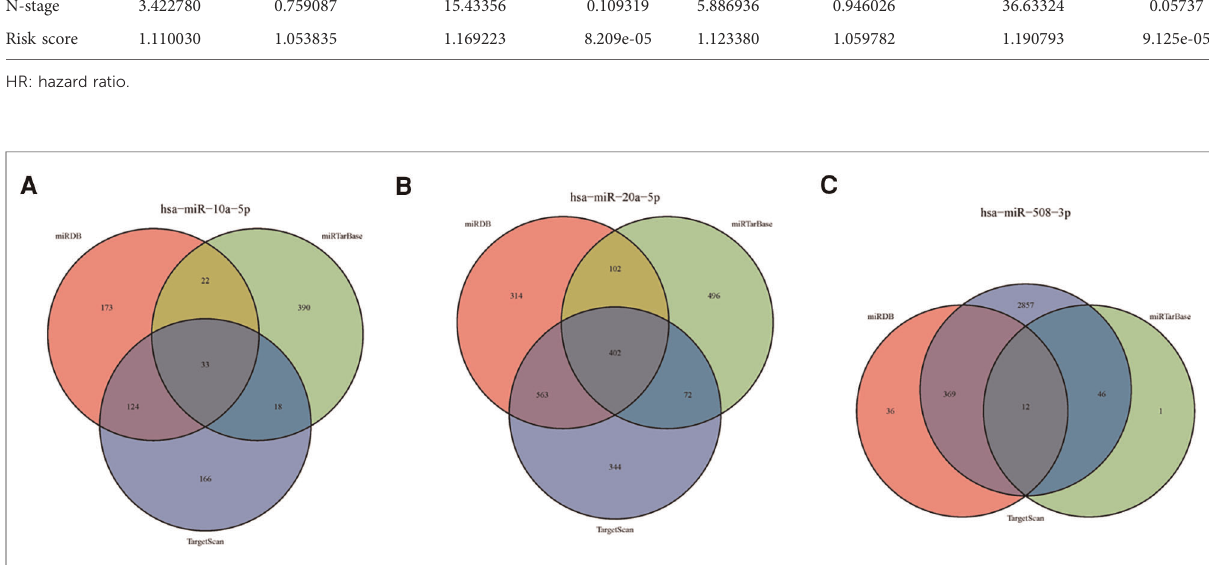
miR-20a-5p, and miR-10a-5p with T-stage. As illustrated in Figure 9E , miR-20a-5p and miR-10a-5p expressed